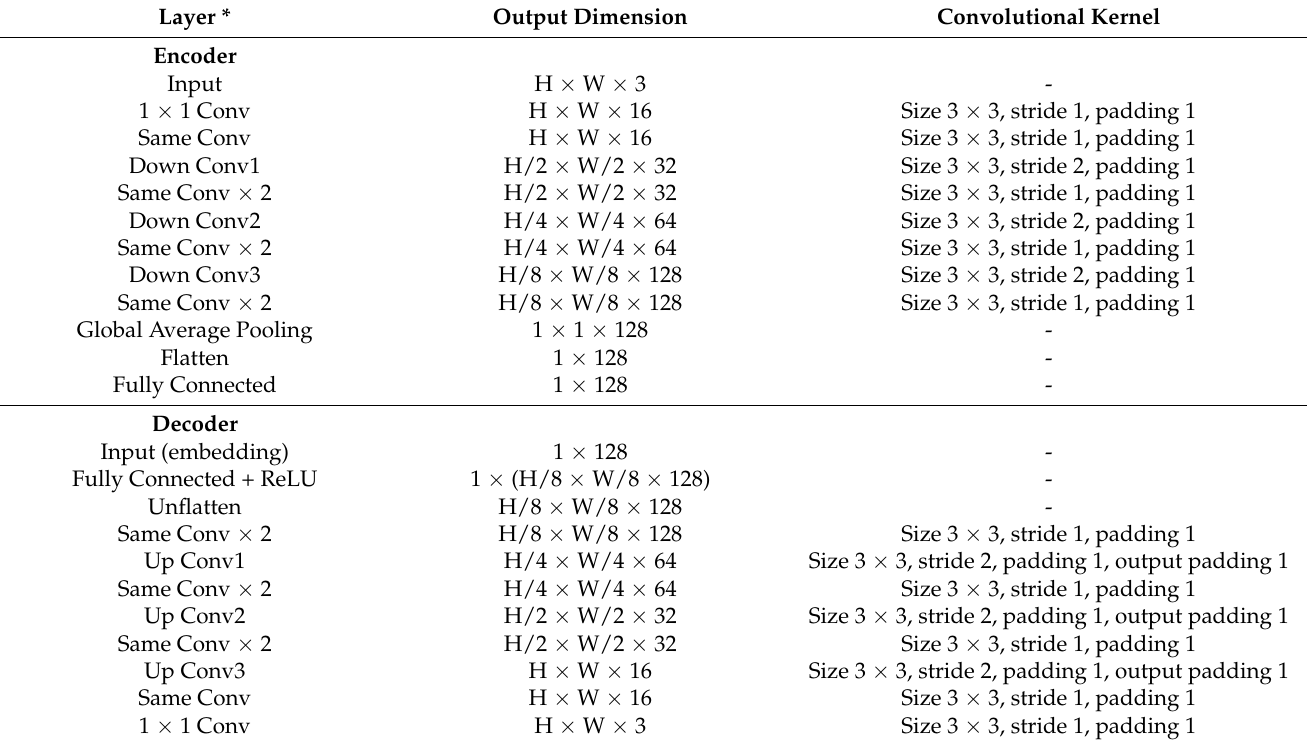
Table 5. Architecture of Model PY autoencoder.